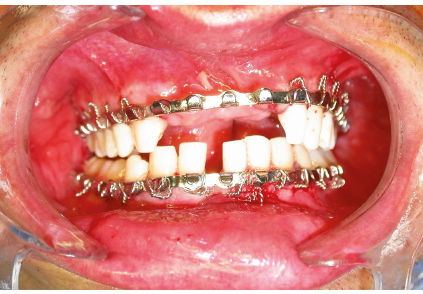
Figure 4: Seven-day postoperative period showing functional occlusion